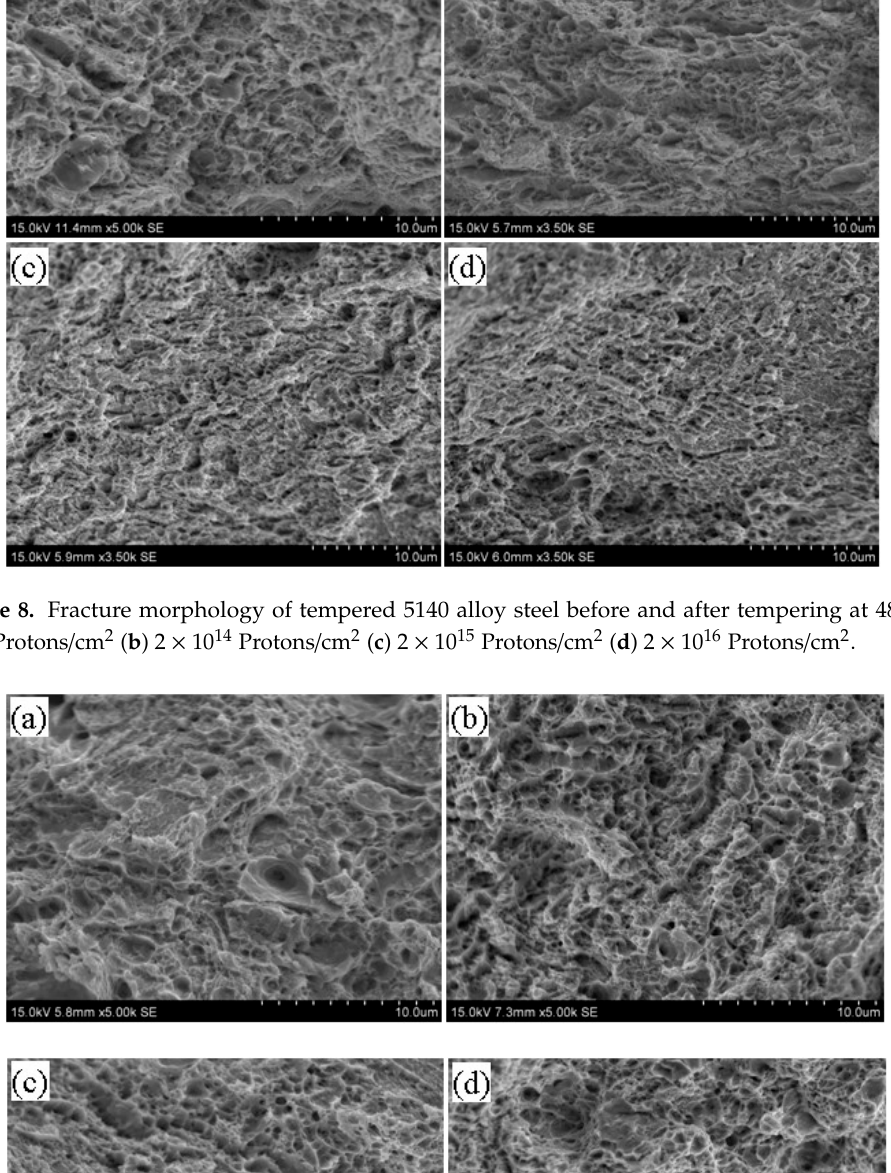
Figure 8. Fracture morphology of tempered 5140 alloy steel before and after tempering at 480 °C ( a ) 0 Protons/cm 2 ( b ) 2 × 10 14 Protons/cm 2 ( c ) 2 × 10 15 Protons/cm 2 ( d ) 2 × 10 16 Protons/cm 2 .